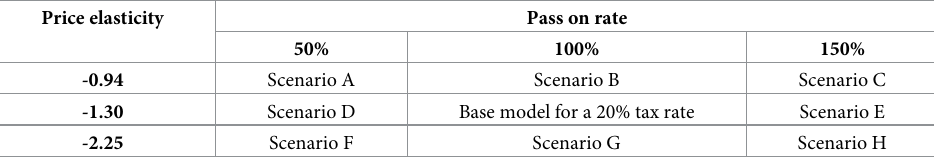
Table 1. Sensitivity analysis scenarios by changing pass on rate and price elasticity.